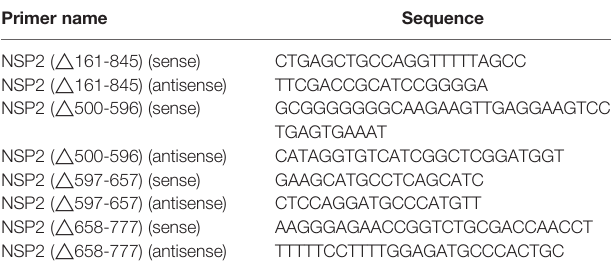
TABLE 3 | Sequence of primers for Q5 ® Site-Directed Mutagenesis Kit mediating NSP2 deletion